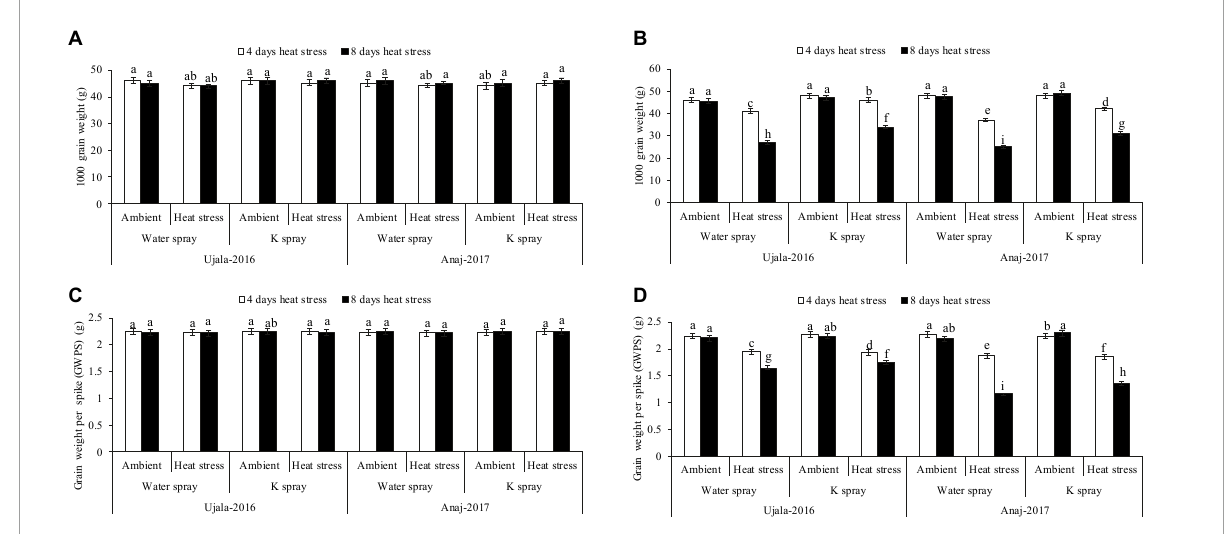
FIGURE2 Impact of optimal, 4 and 8 days of heat stress (1 week after anthesis), potassium (K) spray and cultivars (heat × K × cultivars P < 0.01) on 1,000 grain weight (A) 2019 (B) 2020 and grain weight per spike (C) 2019 (D) 2020 of wheat. Values are the means of four replications ( n = 4) ± SE and variants possessing the same letters are not statistically significant at P < 0.01.